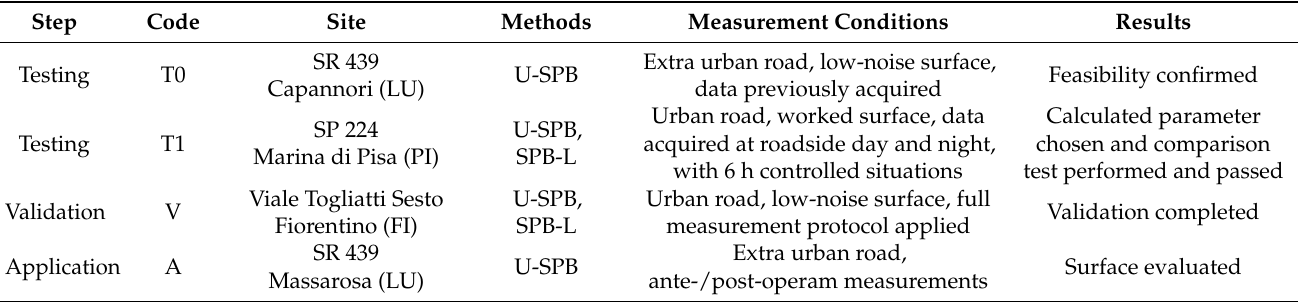
Table 2. Summary of measurement